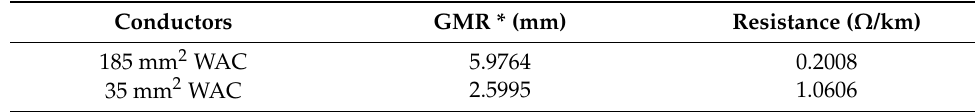
Table A1. Physical parameters of the applied conductors. Conductors